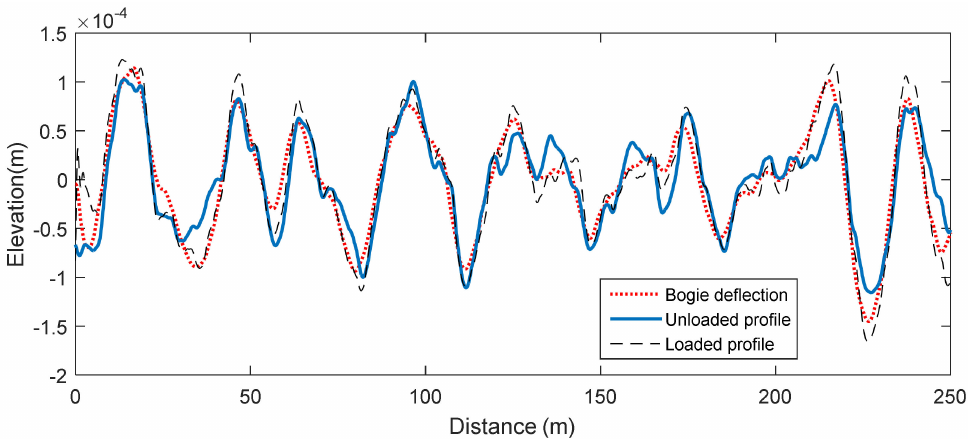
Figure 7. Comparison of BFD to filtered loaded and unloaded